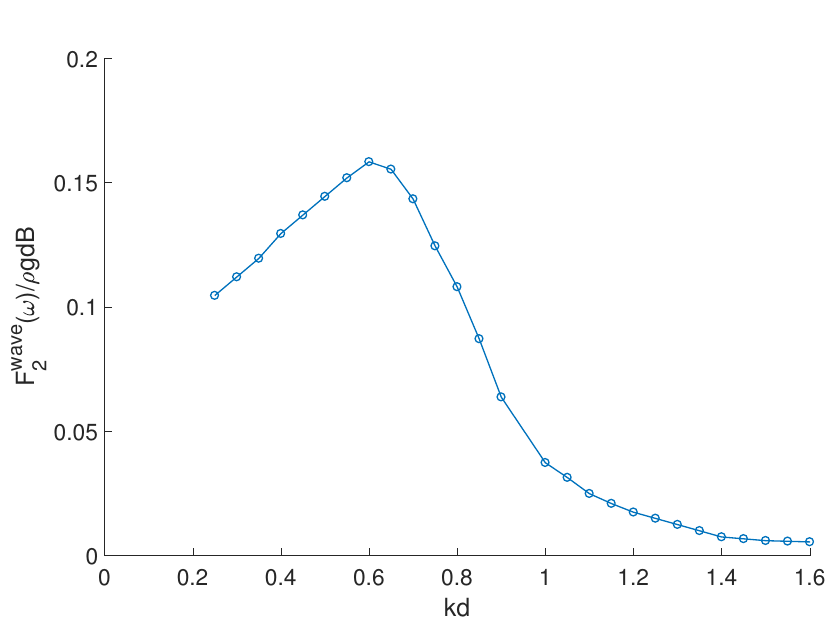
( ω ) on the moored body excited by an incident wave. Figure 20. Wave force F wave 2